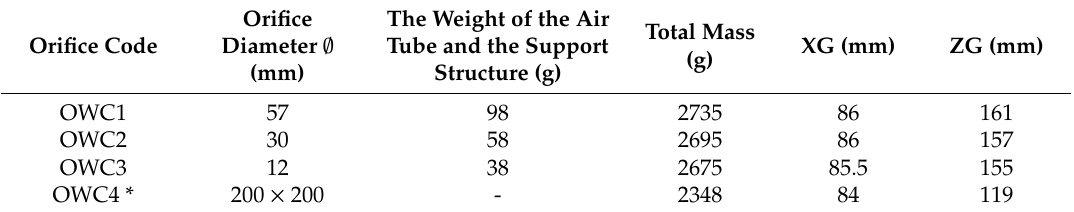
Table 1. Specifications of floating oscillating water column type wave energy converter (OWC WEC) variants with different orifices.